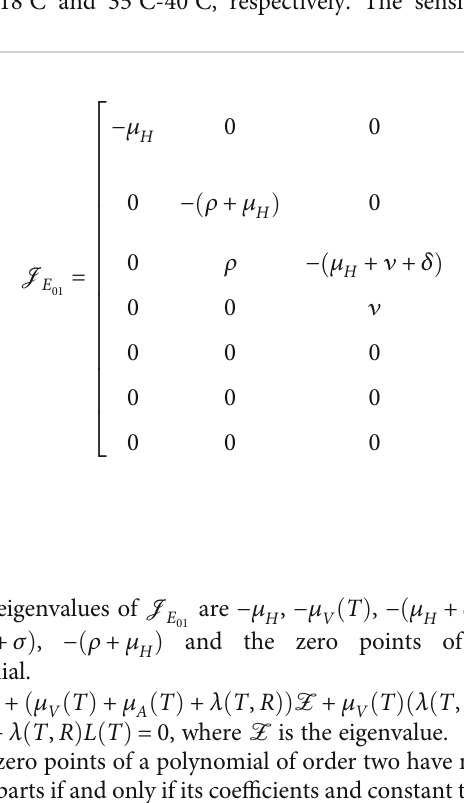
Table 1: Numerical values of sensitivity indices of R